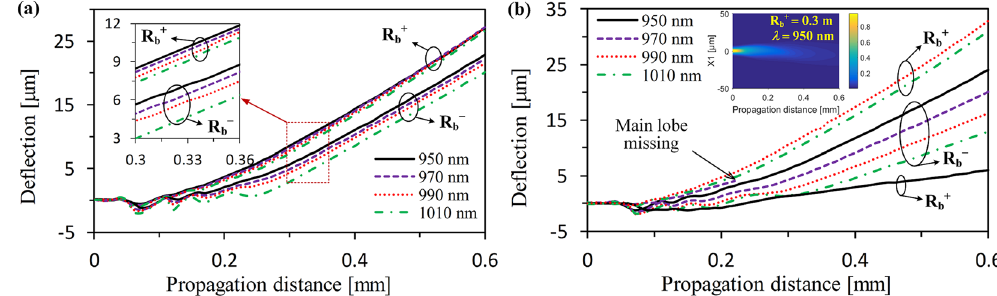
Figure 9. The dynamics of the generated Airy beams for different wavelength during propagation in free space. ( a ) Output beams from 2.2 mm length of the Airy fiber. The inset is corresponding to zoomed-in views. Here R b + and R b − are 0.3 m and − 0.3 m, respectively. ( b ) Output beams from 6.6 mm length of the Airy fiber. The inset indicates the beam’s weak transverse shift due to lack of side lobes.